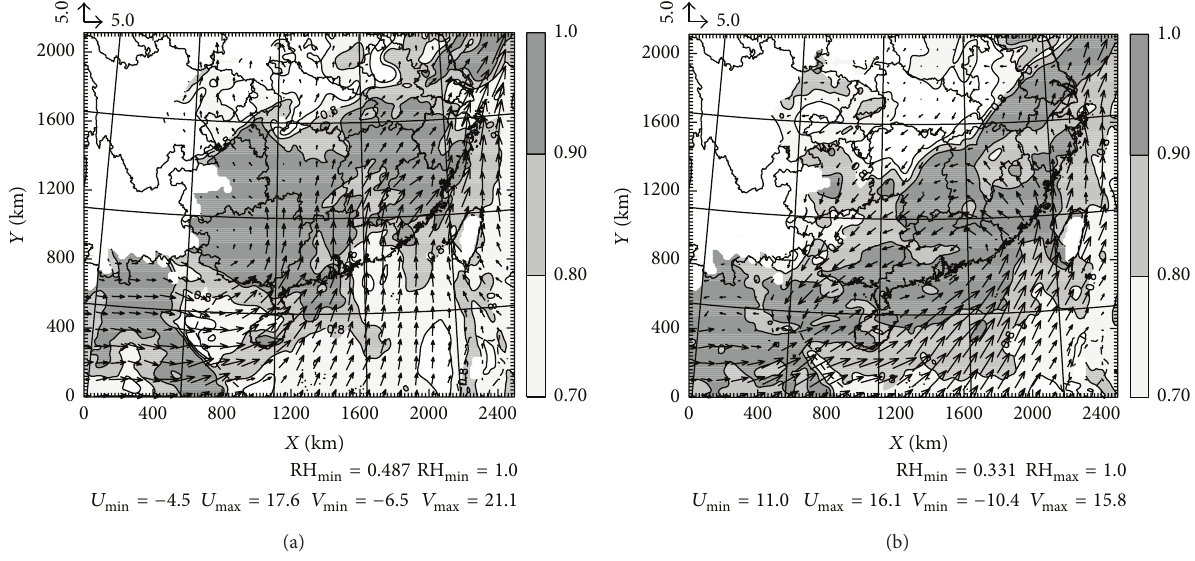
Figure 2: 850hPa wind (arrows, ms −1 ) and relative humidity (shading) at (a) 0000 UTC June 29, 2011 and (b) 0000 UTC July 15,